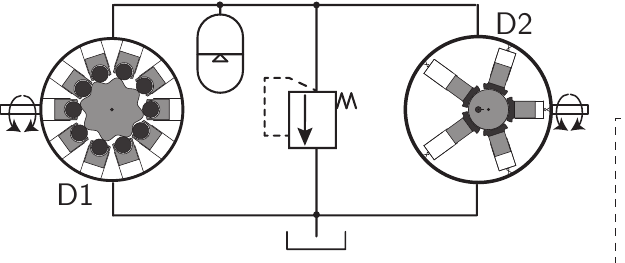
Figure 15: Illustration of a fluid power transmission system comprising two digital displacement machines.